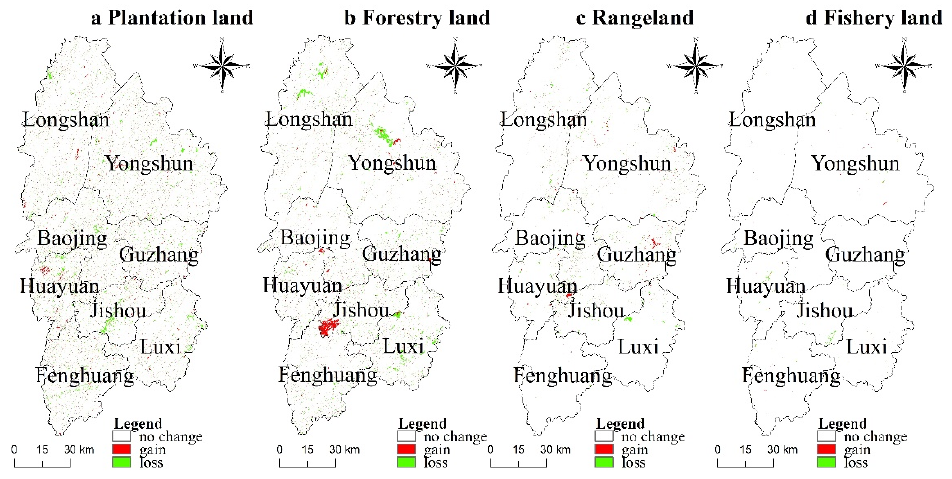
Figure 5. ( a – d ) Spatial distribution of loss and gain for each agricultural land for 2000–2018. Table 5. Statistics of each agricultural land use change for 2000–2018.